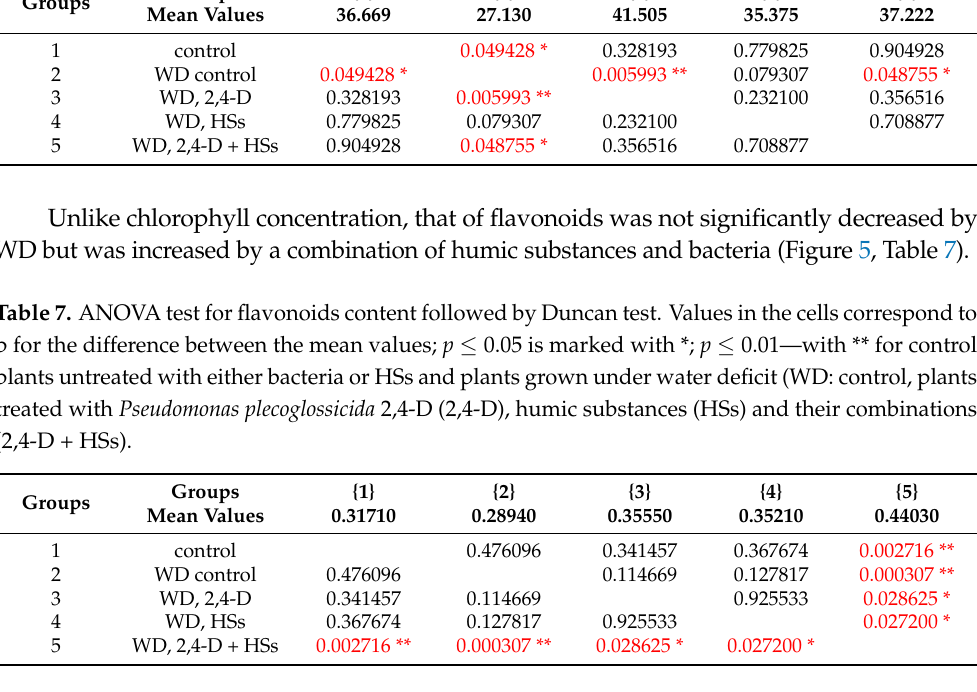
treated with Pseudomonas plecoglossicida 2,4-D (2,4-D), humic substances (HSs) and their combinations